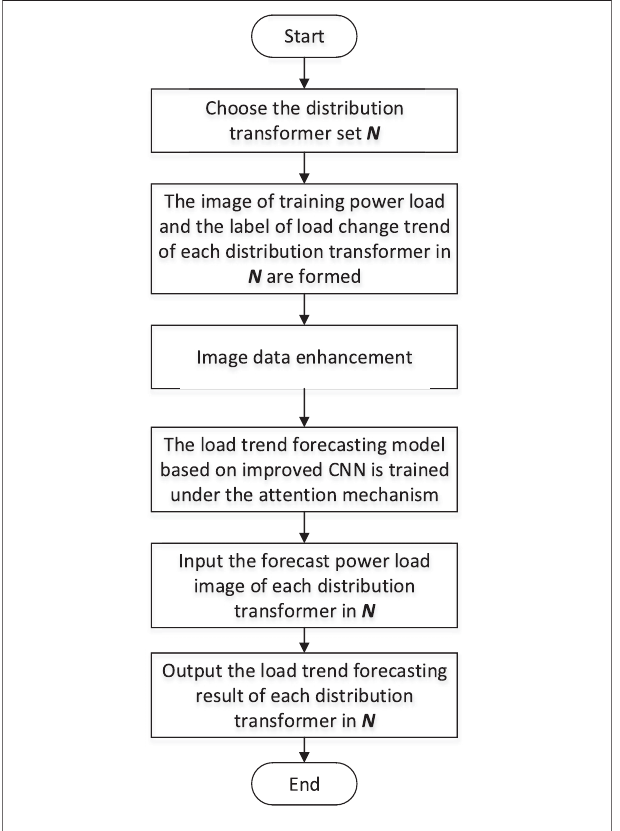
FIGURE 6 | The load trend forecasting link fl ow chart.